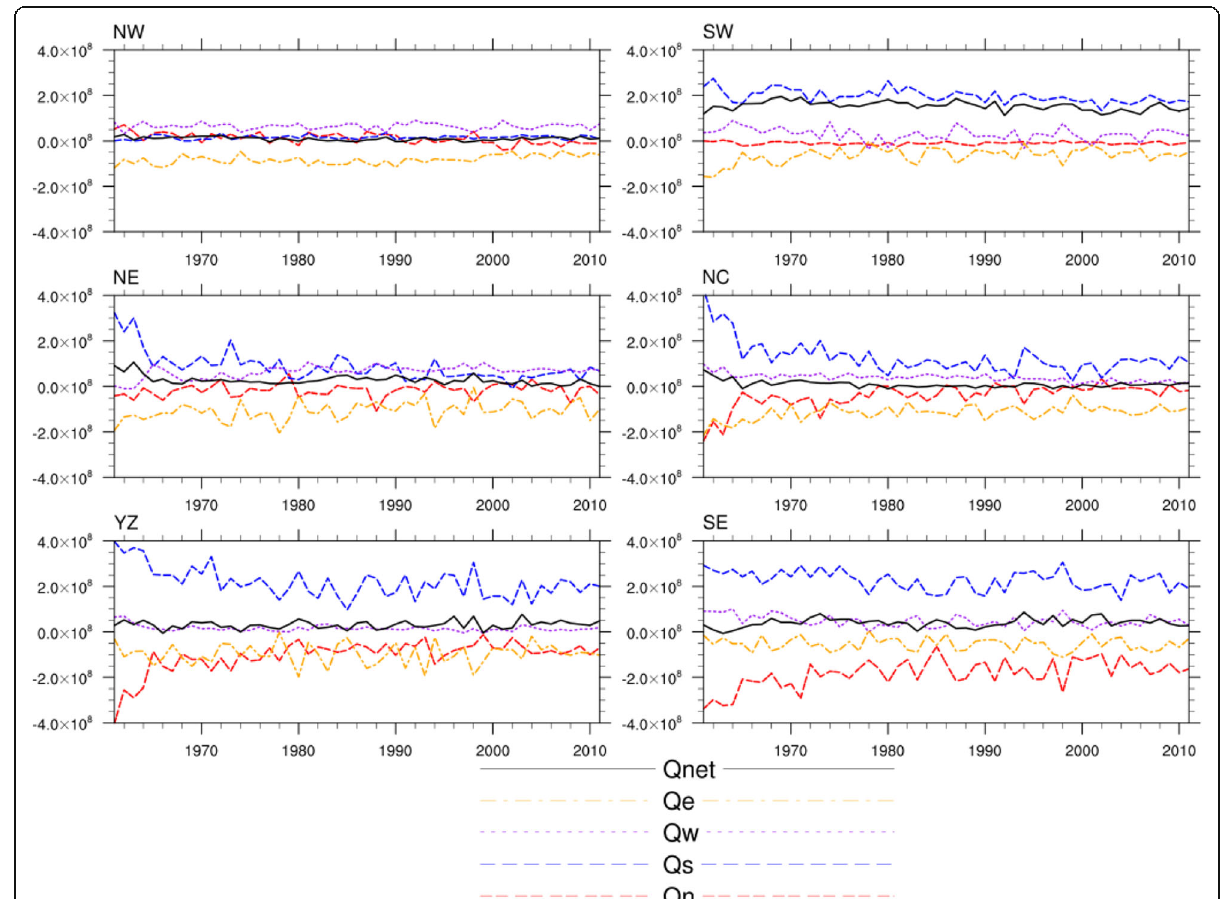
Fig. 7 Yearly variation of the water vapor budget via each regional boundary in summer from 1961 to